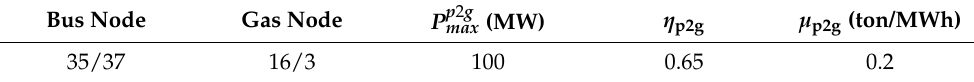
Table A4. Parameters of P2G.